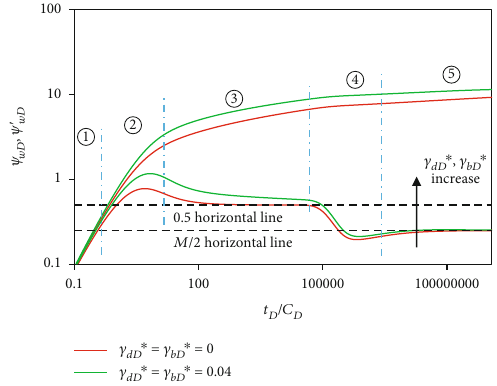
Figure 7: Well test curves for the pressure buildup well test in composite gas reservoir.